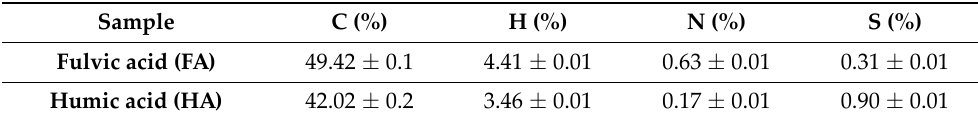
Figure 5. Biomass of fungi in incubations. Table 2. The elemental composition of commercial